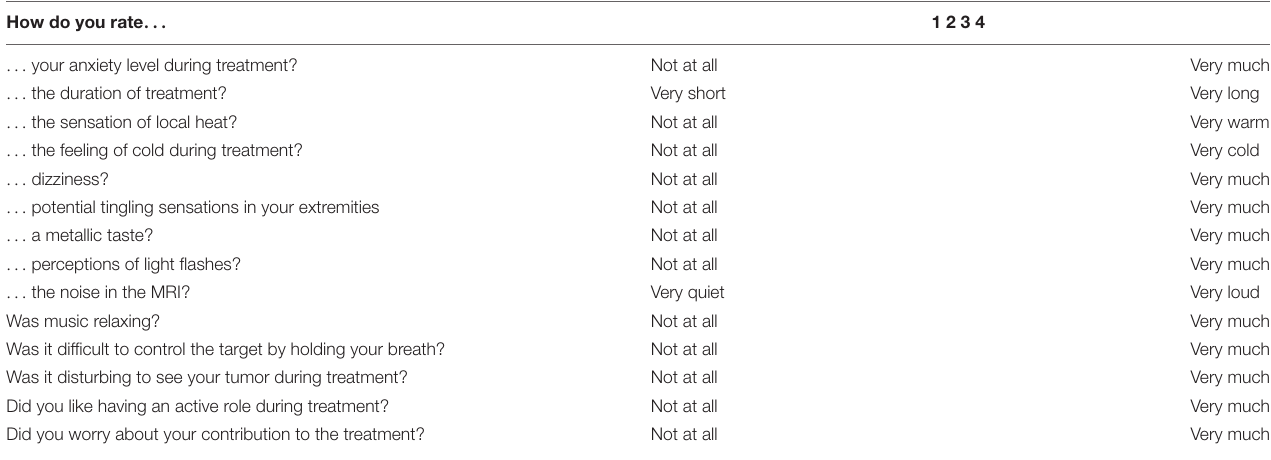
TABLE 1 | Patient-reported outcome (PRO) questionnaire. How do you rate